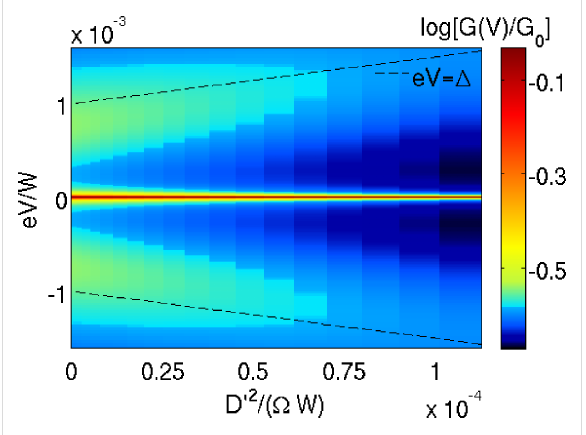
Figure 2: Logarithmic color plot of the SMM differential conductance G ( V ) normalized to the value and for T = 0. Parameters are S = 3/2, D = 5 · 10 − 4 W , E = 0.1 D , E ′ = 0, Ω = 0.5 D , J = 0.2 W and D ′ is varied. The dashed line represents the renor- malized ZFS from Equation 3.